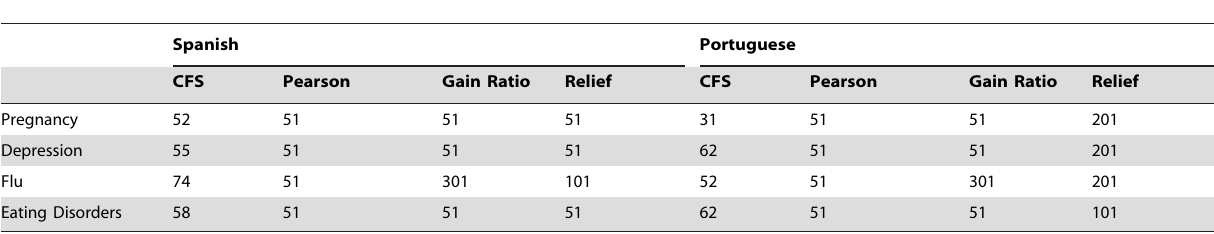
Table 6. Number of features selected by each selection method.